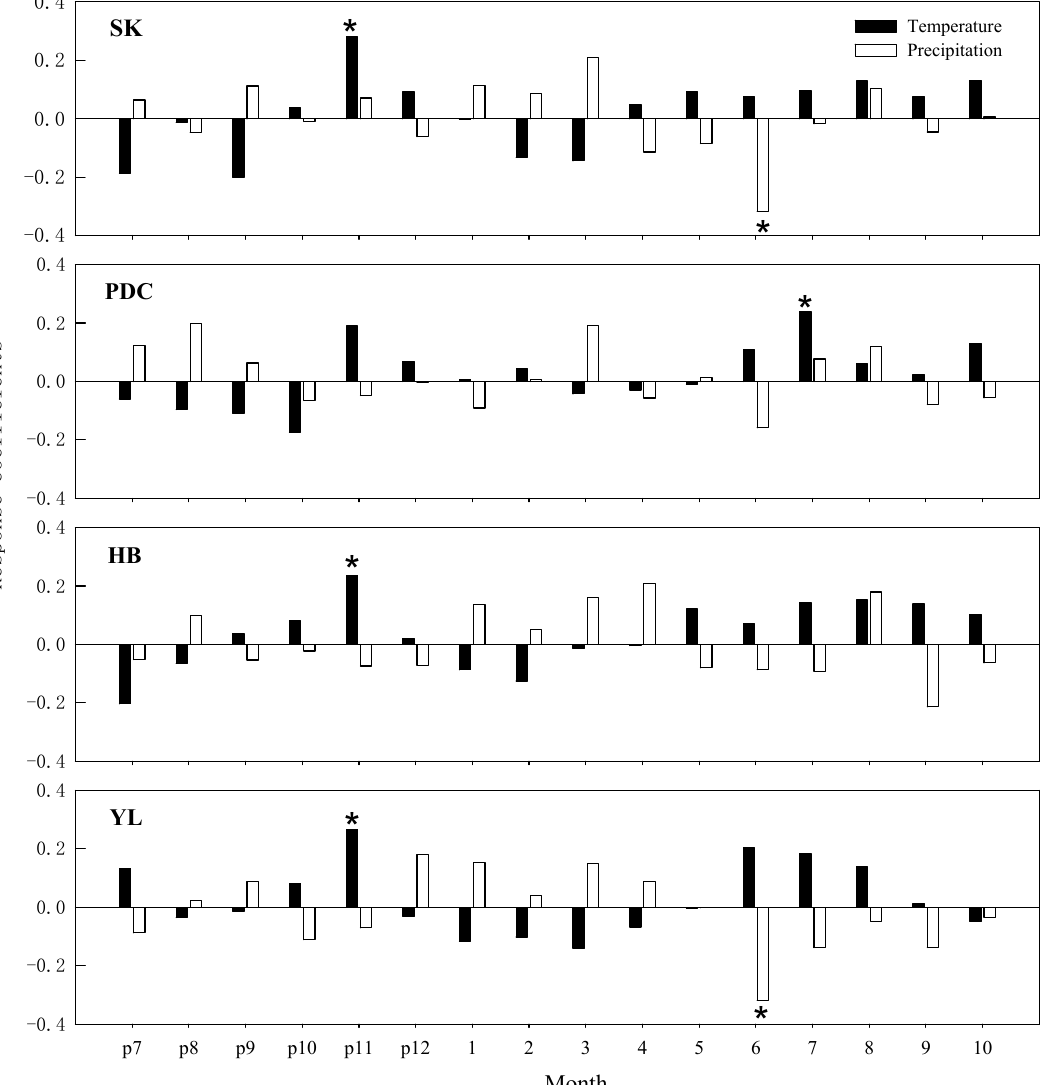
Figure 5. Correlation coefficients from the response function analysis between the residual chronologies and the monthly climate variables at four sites over the period 1961–2010. * indicates a significant relationship at p < 0.05. p: previous year, the same below.